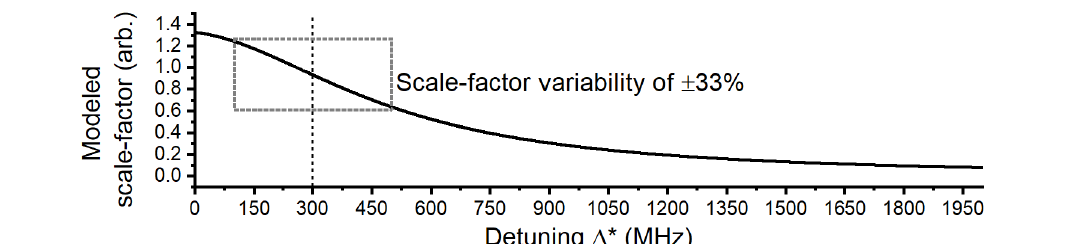
Figure 9. Using Equation (3), the variation of the scale-factor is modeled for ambient temperature changes of ± 0.2 ◦ C, corresponding to a thermal WGM shift of ≈ ±